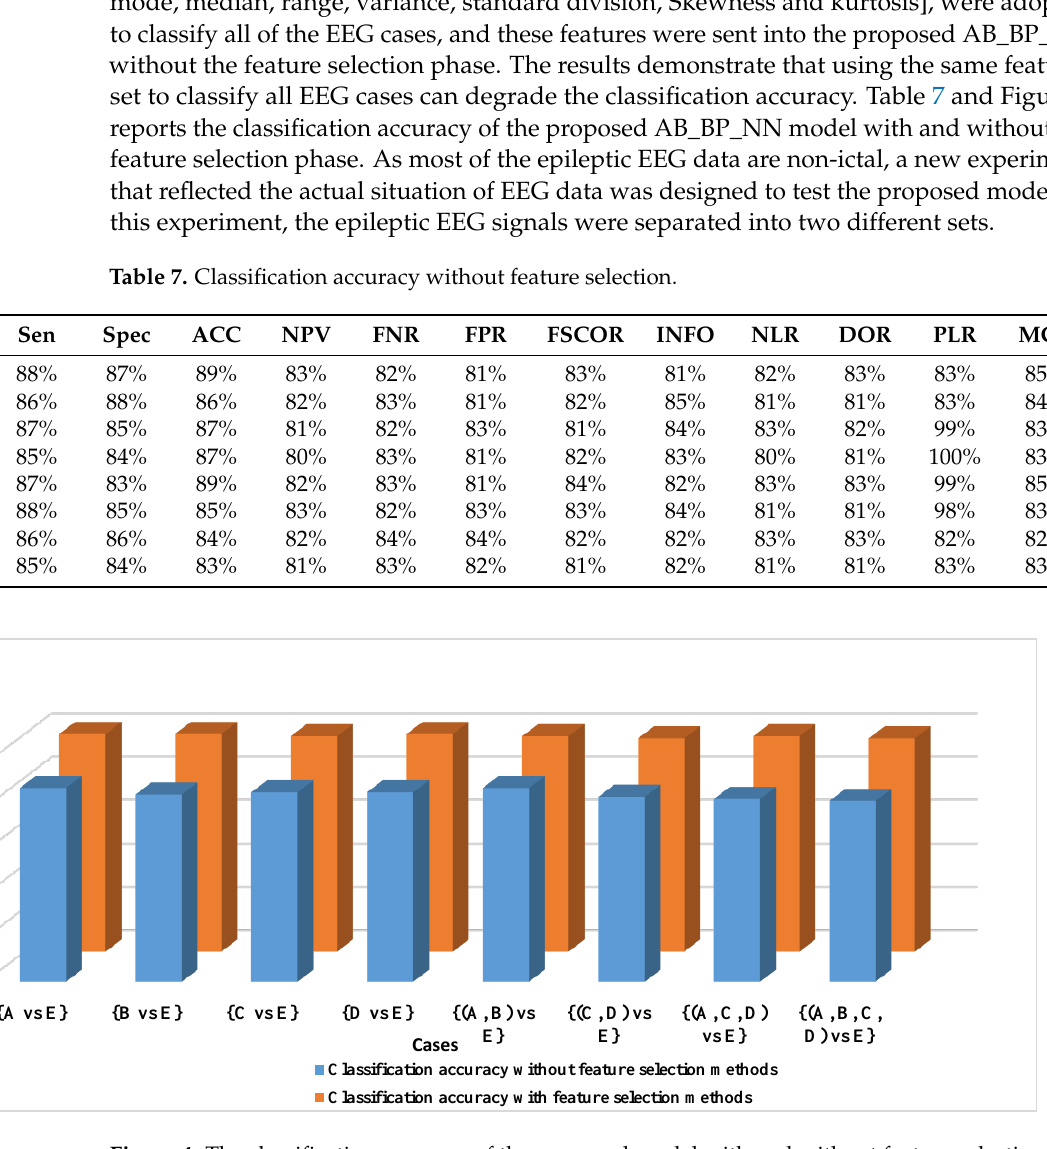
Figure 4. The classification accuracy of the proposed model with and without feature selection.